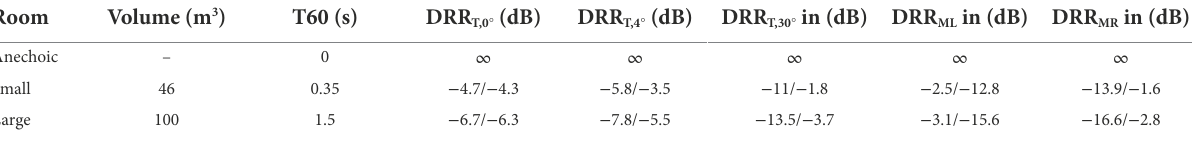
TABLE 2 Room acoustical properties of the three different rooms.